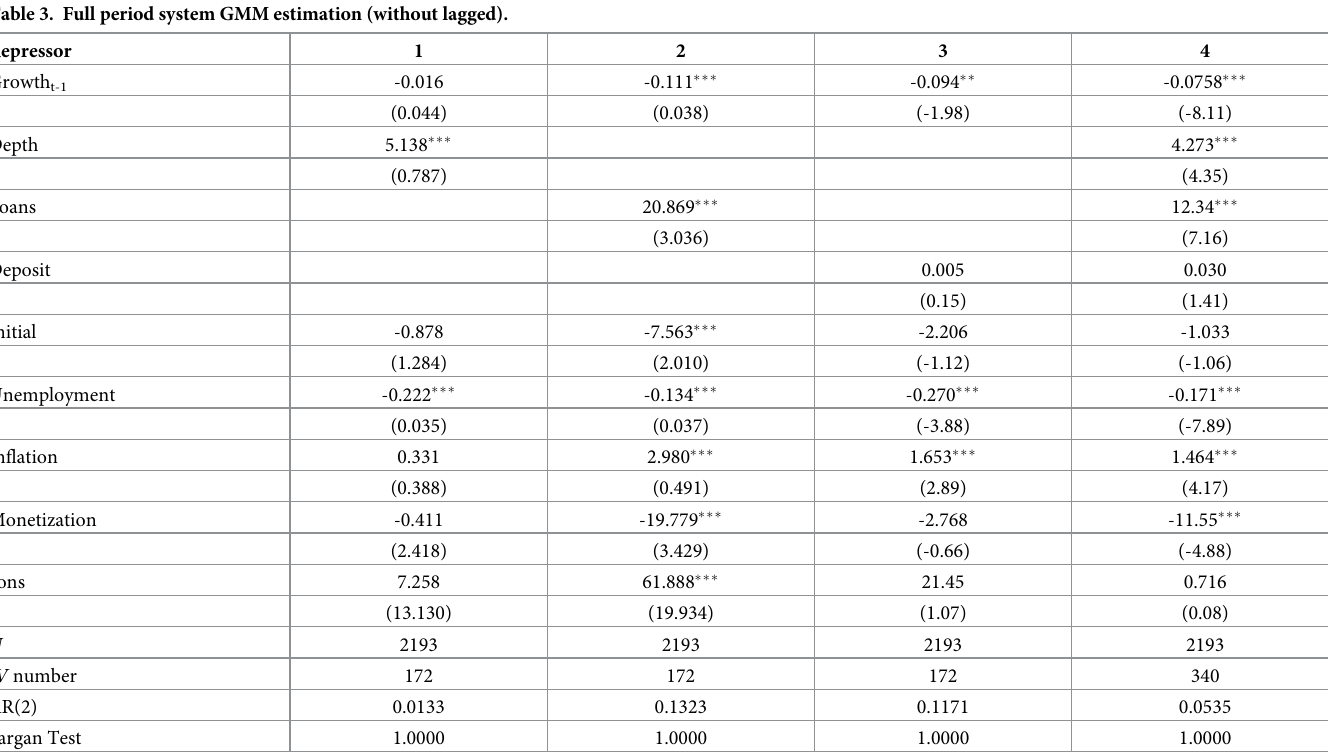
Table 3. Full period system GMM estimation (without